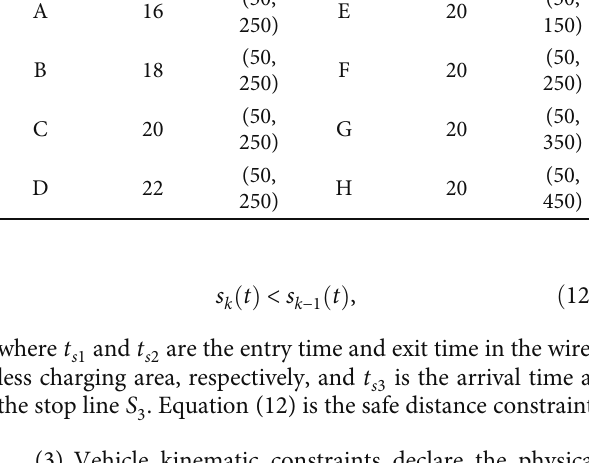
Table 4: Parameter setting of eight scenarios. Initial speed Scenario